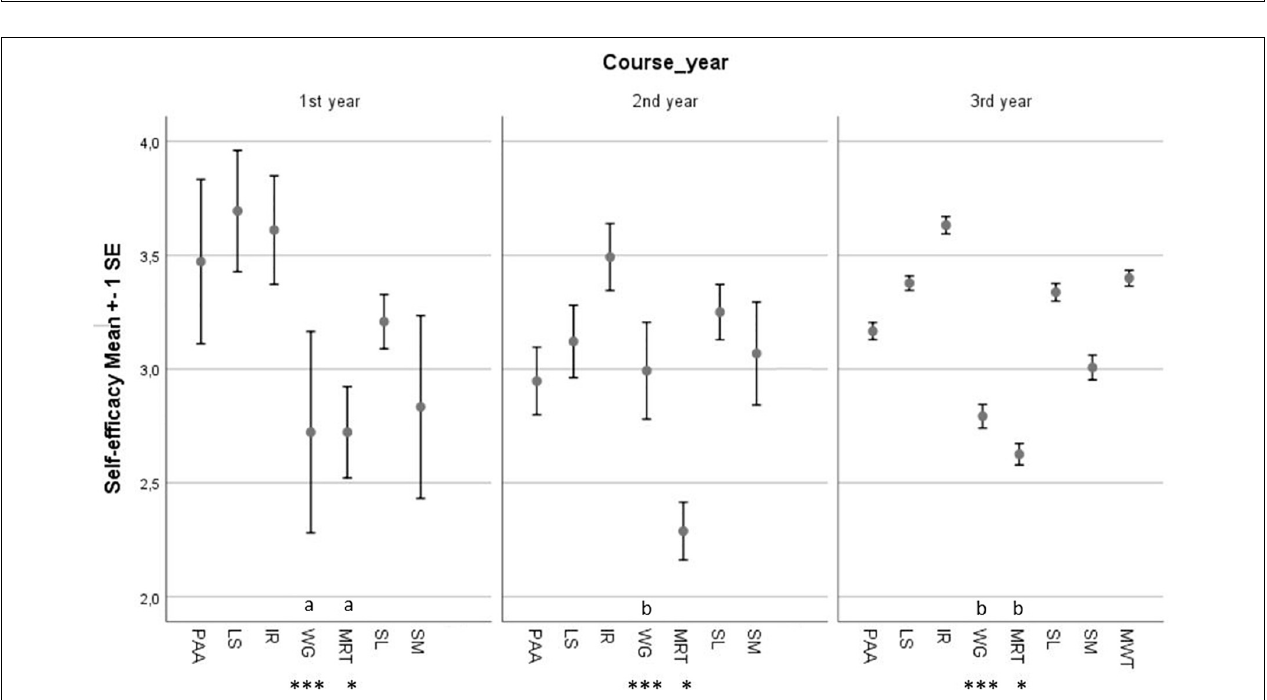
FIGURE 2 | Mean levels of the Academic Self-efficacy factors for students at the first, second, and third year of the undergraduate degree course and results from univariate analysis of variance and post hoc comparisons based upon Tukey tests. ∗ p < 0.05; ∗∗∗ p < 0.001; Different letters indicate significant differences among groups; PAA, “Planning Academic Activities”; LS, “Learning Strategies”; IR, “Information Retrieval”; WG, “Working in Groups”; MRT, “Management of Relationships with Teachers”; SL, “Skills for Lessons”; SM, “Stress Management.”